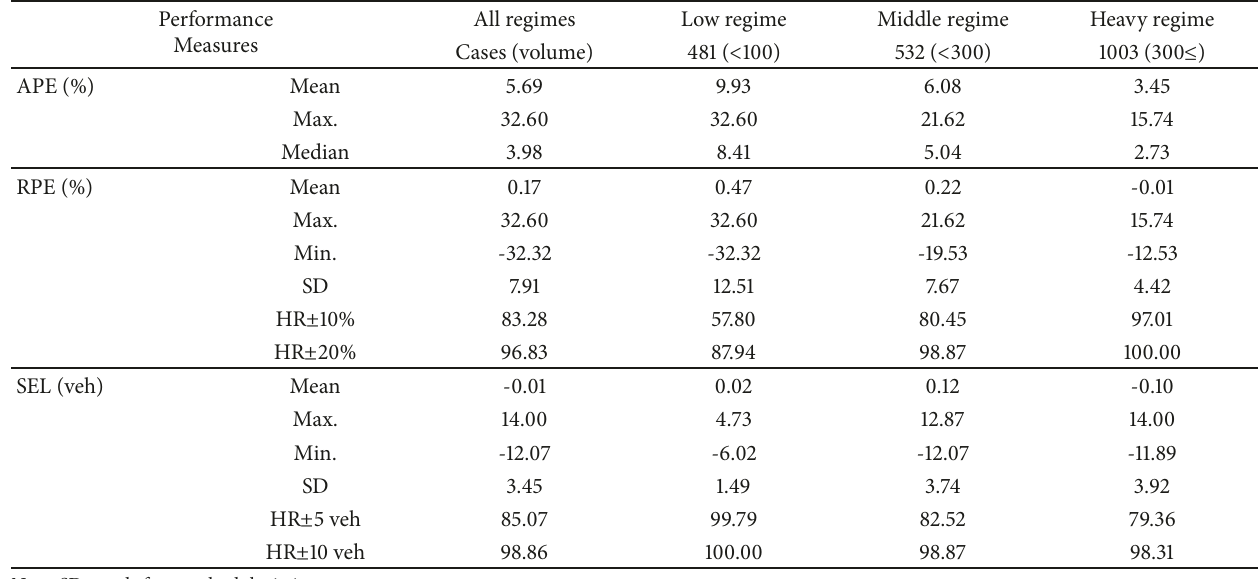
Table 1: Summary of the results.